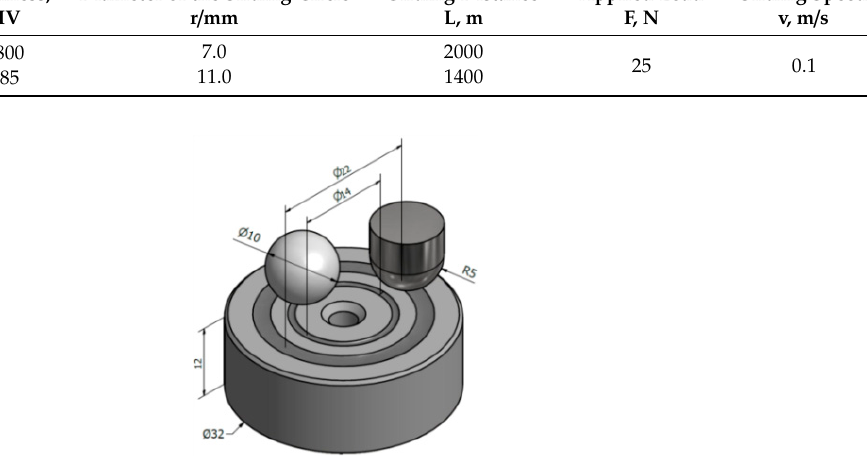
Figure 2. An example of a sample used during the pin-on-disc tests and two types of applied pins as counterbodies; dimensions are given in mm.